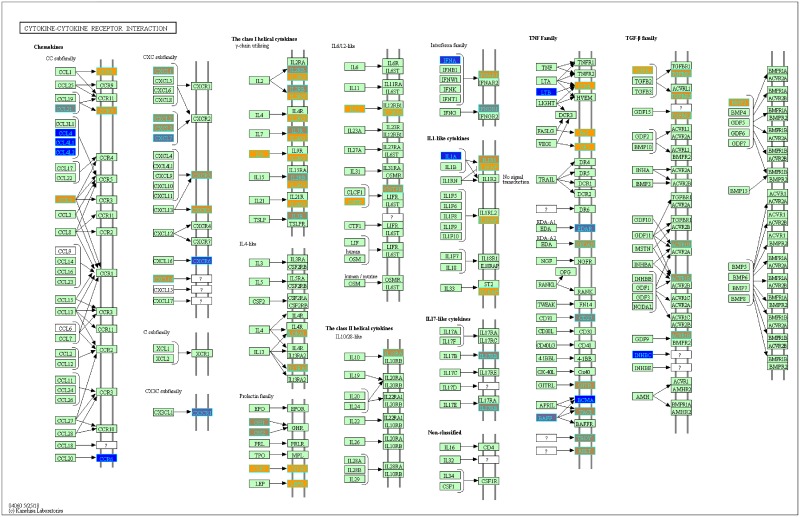
Highlighted Cytokine-cytokine receptor interaction KEGG pathway (hsa04060)with enriched genes from the LRT (q-value < 0.05) [49–51].Yellow-colored genes are up-regulated and blue-colored genes are down-regulated in COPD samples.